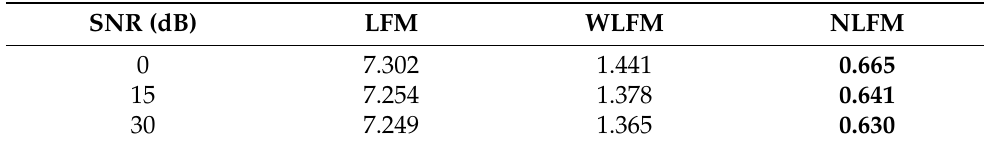
Table 1. The RMSE of the pedestrian velocity (m/s).